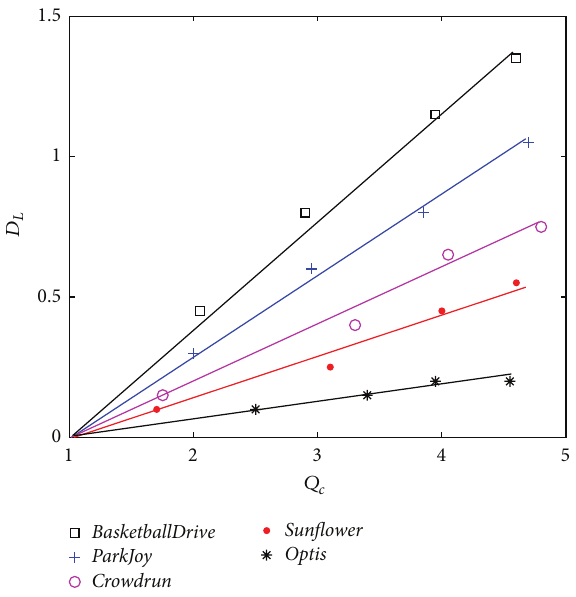
Figure 5: Relationship between 𝑄 𝑐 and 𝐷 𝑙 .